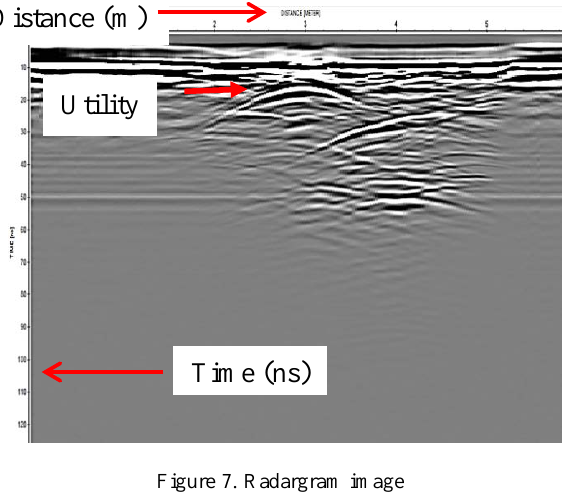
Figure 7 . Radargram